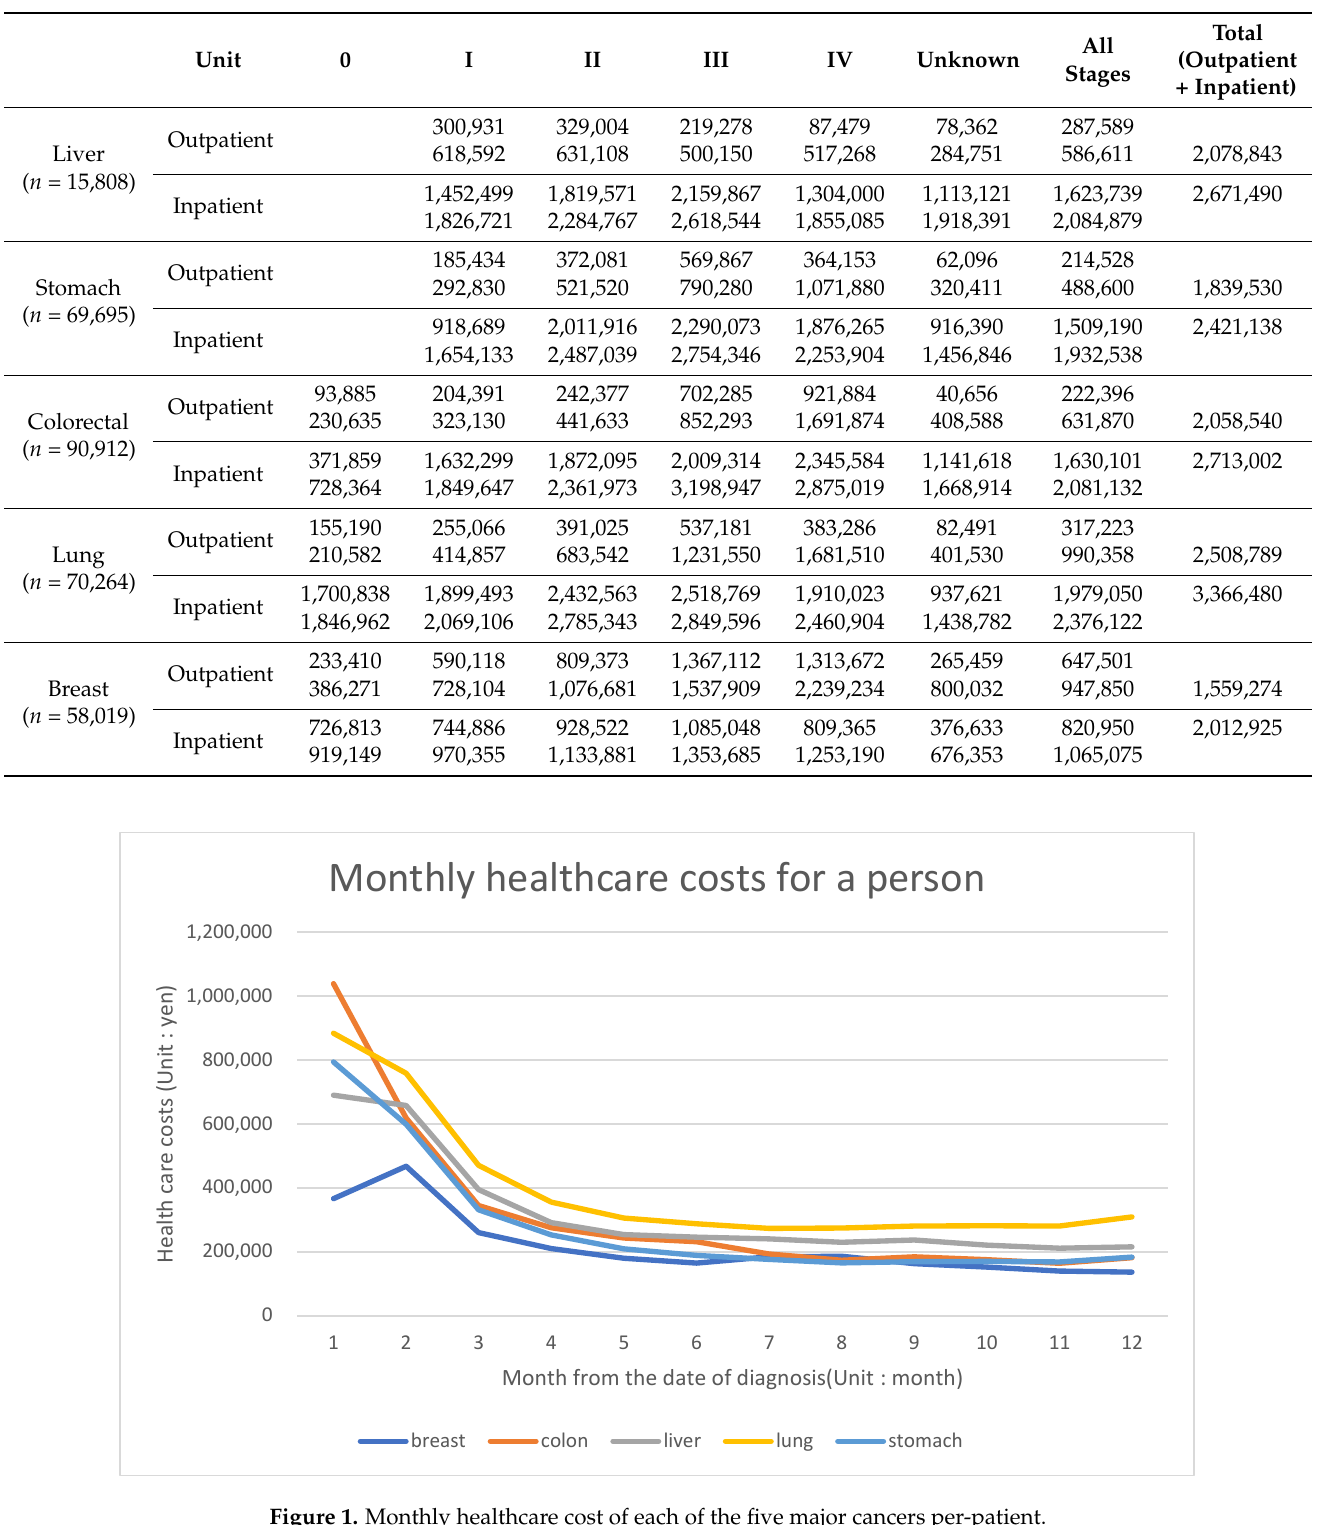
Figure 2. Monthly healthcare cost of each of the five major cancers per-patient stratified by age. 3.2. Number of Outpatient Visits in a Year Table 3 presents the trend for the number of outpatient visits and hospitalization. Breast cancer showed the highest median number of outpatient visits (25 visits), while other cancers obtained less than 15 visits. In addition, the median number of hospitaliza- tions was within the range of 1 – 3. Together with other factors, outpatient visits impacted